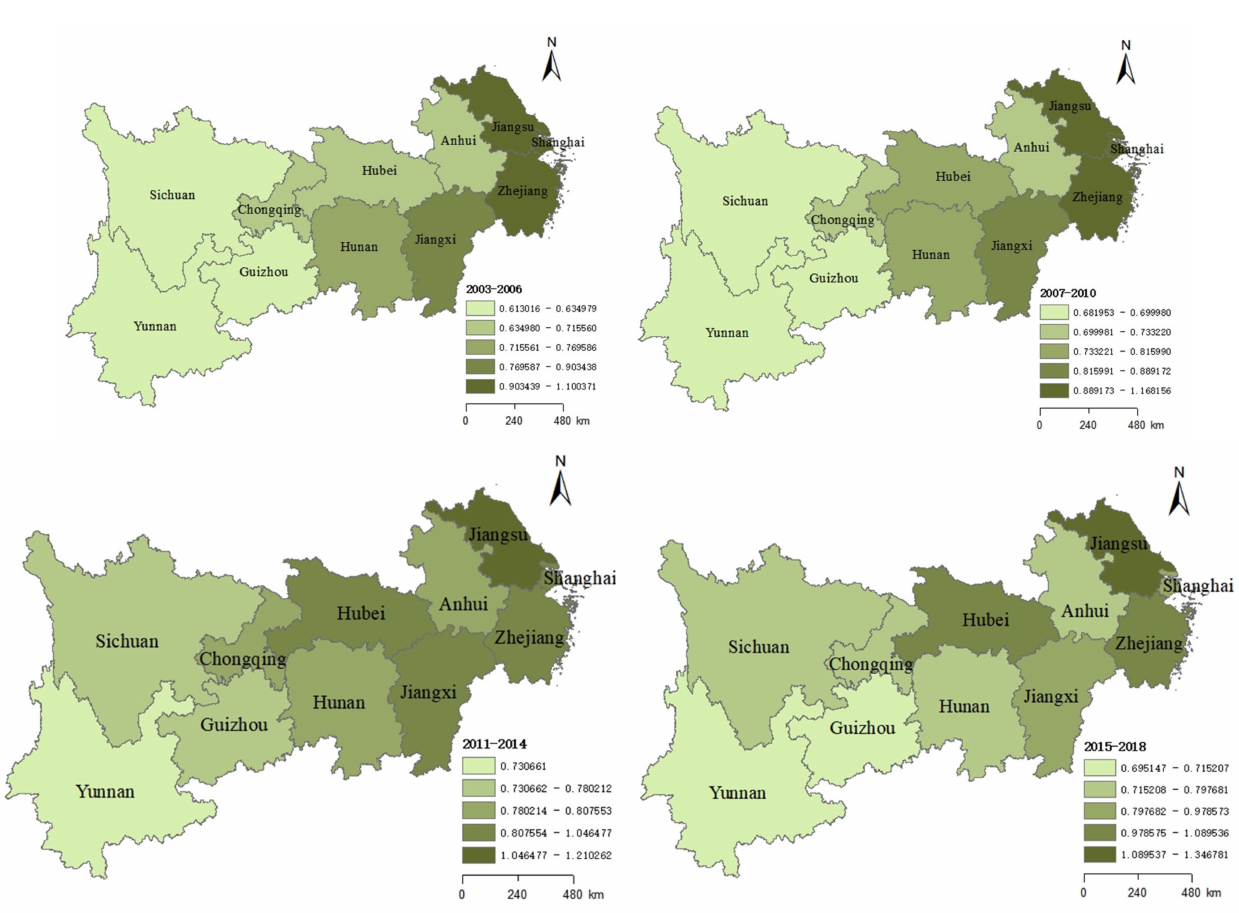
Figure 4. Changes of the CIGTFEE in YREB from 2003 to